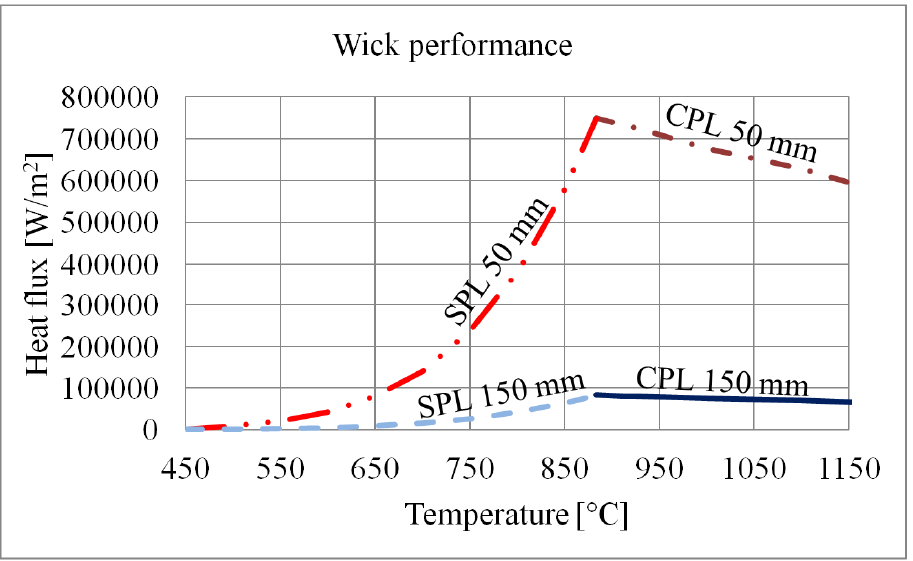
Figure 9. The theoretical performance of the tape cast wick with potassium working fluid. SPL = Static pressure limited. CPL = Capillary pressure